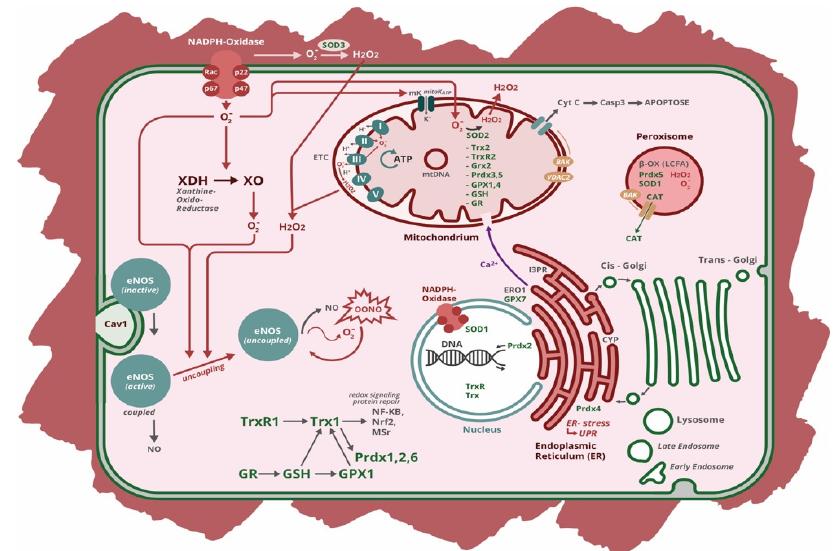
Figure 1. Subcellular generation of reactive oxygen species and the resolving antioxidative defense. The redox potential of redox pairs as well as the concentration of ROS depend on the subcellular compartment. The concentration of H 2 O 2 , for instance, has been determined to be around 80 pM in the cytosol, 20 nM in the mitochondria, 700 nM in the endoplasmatic reticulum and 1–5 μ M in the extracellular space (see shades of red). (Abbreviations: NOX: NADPH Oxidase; XDH: xanthine dehydrogenase; XO: xanthine oxidase; SOD: superoxide dismutase; Trx: thioredoxin, TrxR: thioredoxin reductase; GSH: glutathione; GR: glutathione reductase; GPX: glutathione peroxidase; Grx: glutaredoxin; Prdx: peroxiredoxin; eNOS: endothelial nitric oxide synthase; NO: nitric oxide; Cav1: caveolin-1; Ero1: ER oxidoreductin 1; I3PR: inositol-3-phosphate receptor; Cyt C: cytochrome C; Casp3: caspase 3; CAT: catalase; ß-OX: ß-oxidation; LCFA: long chain fatty acid; ETC: electron transport chain; mtDNA: mitochondrial DNA; CYP: cytochrome P450; UPR: unfolded protein response; VDAC: voltage- dependent anion channel; BAK: Bcl-2-homologous antagonist killer protein).